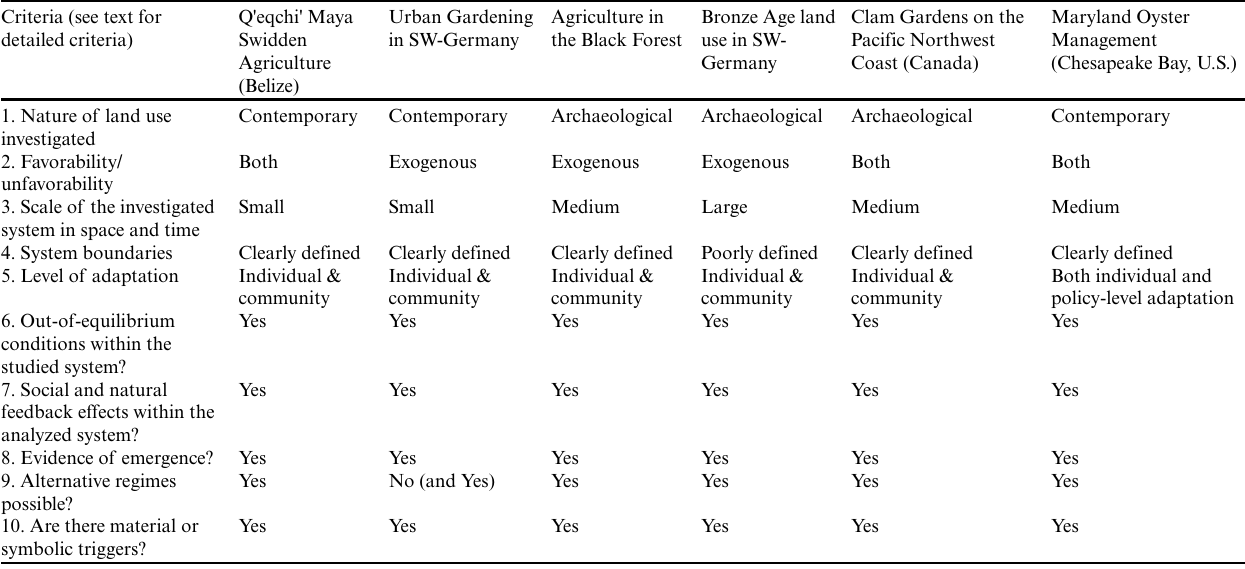
Table 2 . Summary of case study data evaluated under the rubric of complex adaptive systems criteria. Criteria (see text for detailed